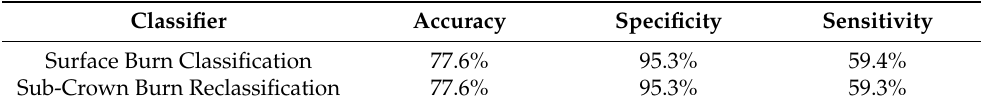
Table 4. Surface Burn Classification and Sub-Crown Burn Reclassification Results.